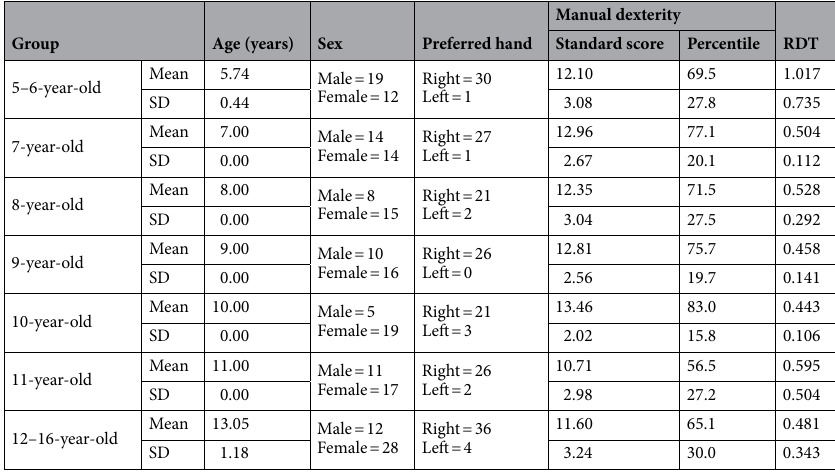
Table 2. Summary of data for each age group. RDT action-outcome regularity detection threshold, SD standard deviation.